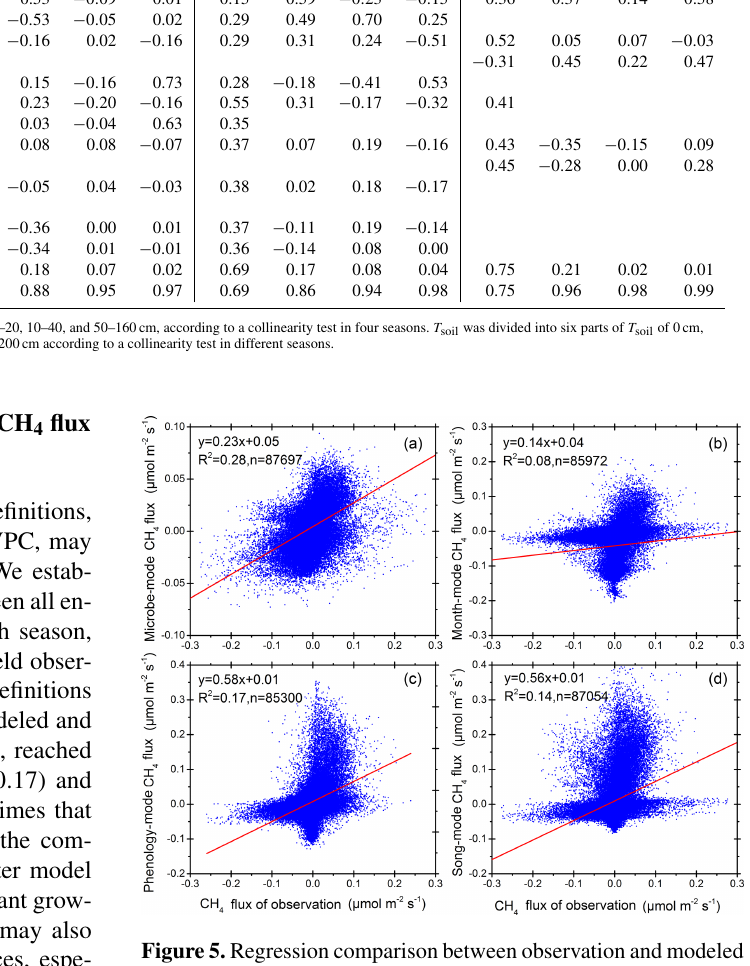
Figure 5. Regression comparison between observation and modeled methane fluxes with four different seasonal definitions and classifi- cation models. Panels (a) , (b) , (c) , and (d) are for the SMT, JMC, VCT, and VPC methods,